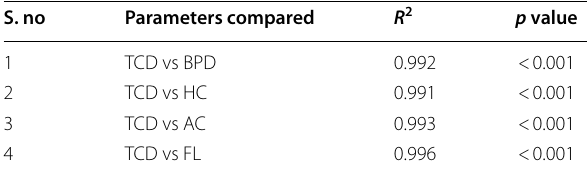
Table 3 Correlation of TCD with BPD, HC, AC and FL